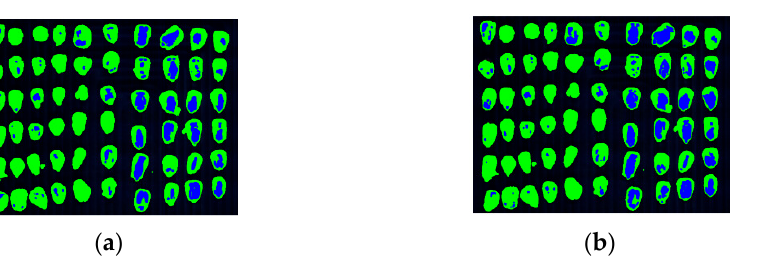
Figure 13. Classification results of SVM and LDA in corn kernel mildew hyperspectral image data (spectral and image features) ( a ) SVM and ( b ) LDA.